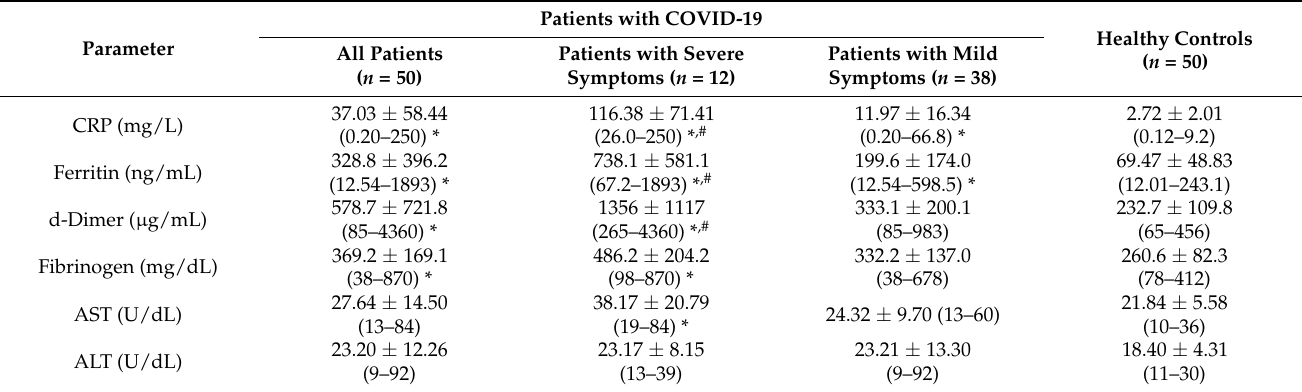
Table 3. Biochemical parameters of the study